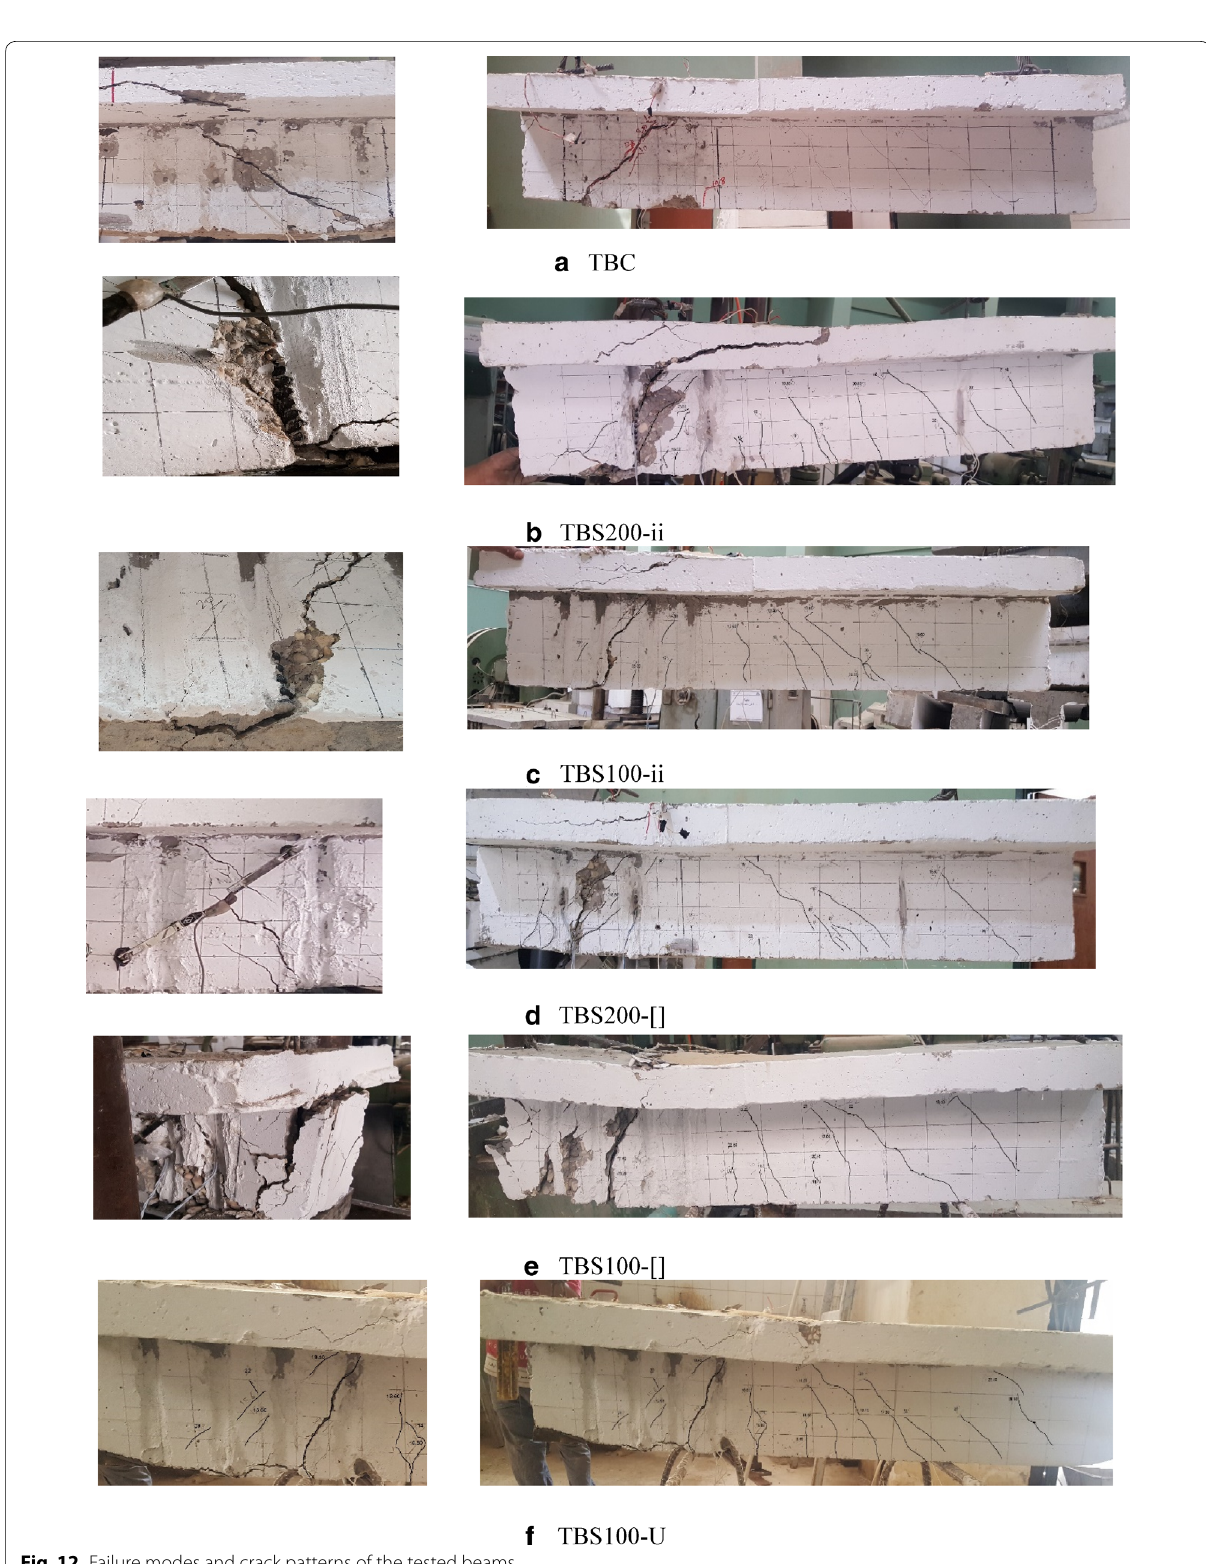
Fig. 12 Failure modes and crack patterns of the tested